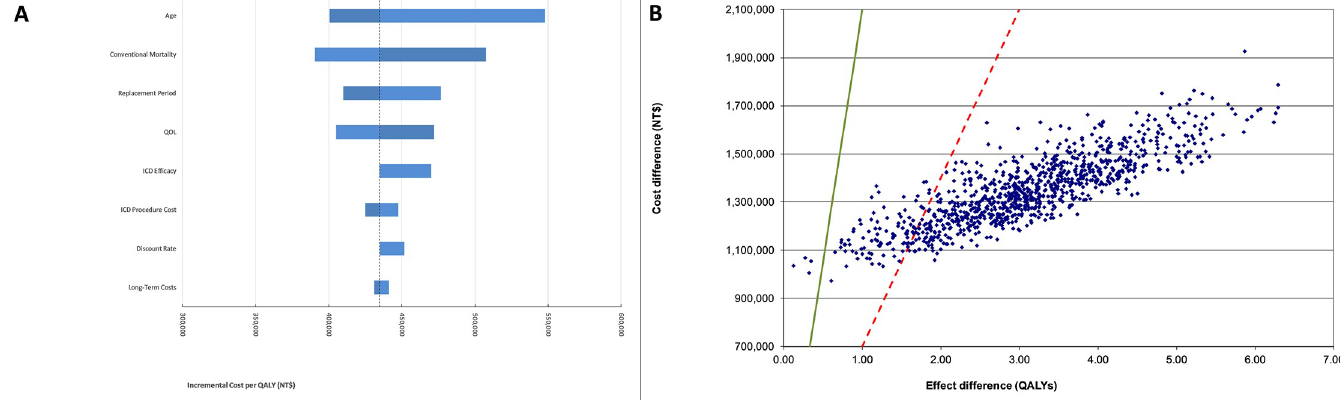
Table 2. Base case scenario results (primary prevention and 1.5 primary prevention).